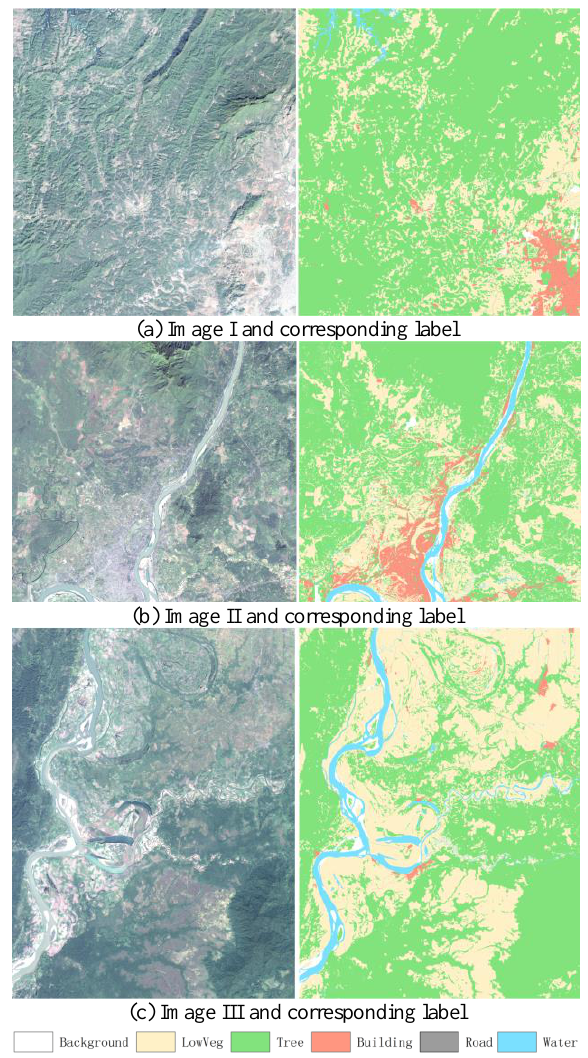
Figure 3. The images and annotated labels in the dataset